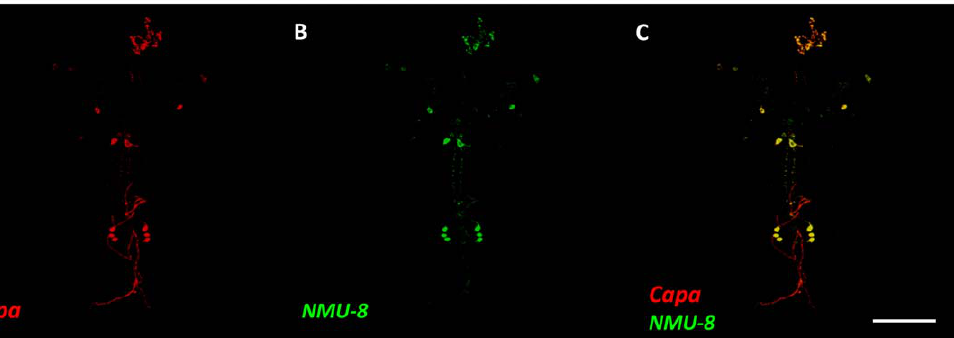
Figure 5. Immunocytochemical localization of the capa-expressing neurons with a vertebrate NMU antibody. Larval central nervous system was doubly labeled using an antibody against capa precursor ( A , red), an antibody against porcine neuromedinU-8 ( B , green). The immunoreactive cells bodies and neurohemal organs, the retrocerebral complex for the 2 cell bodies in the subesophageal neuromere, and the abdominal median transverse nerves for the 3 pairs of abdominal neuroendocrine cells all co-localize ( C , yellow, merge). Scale bar 100 m